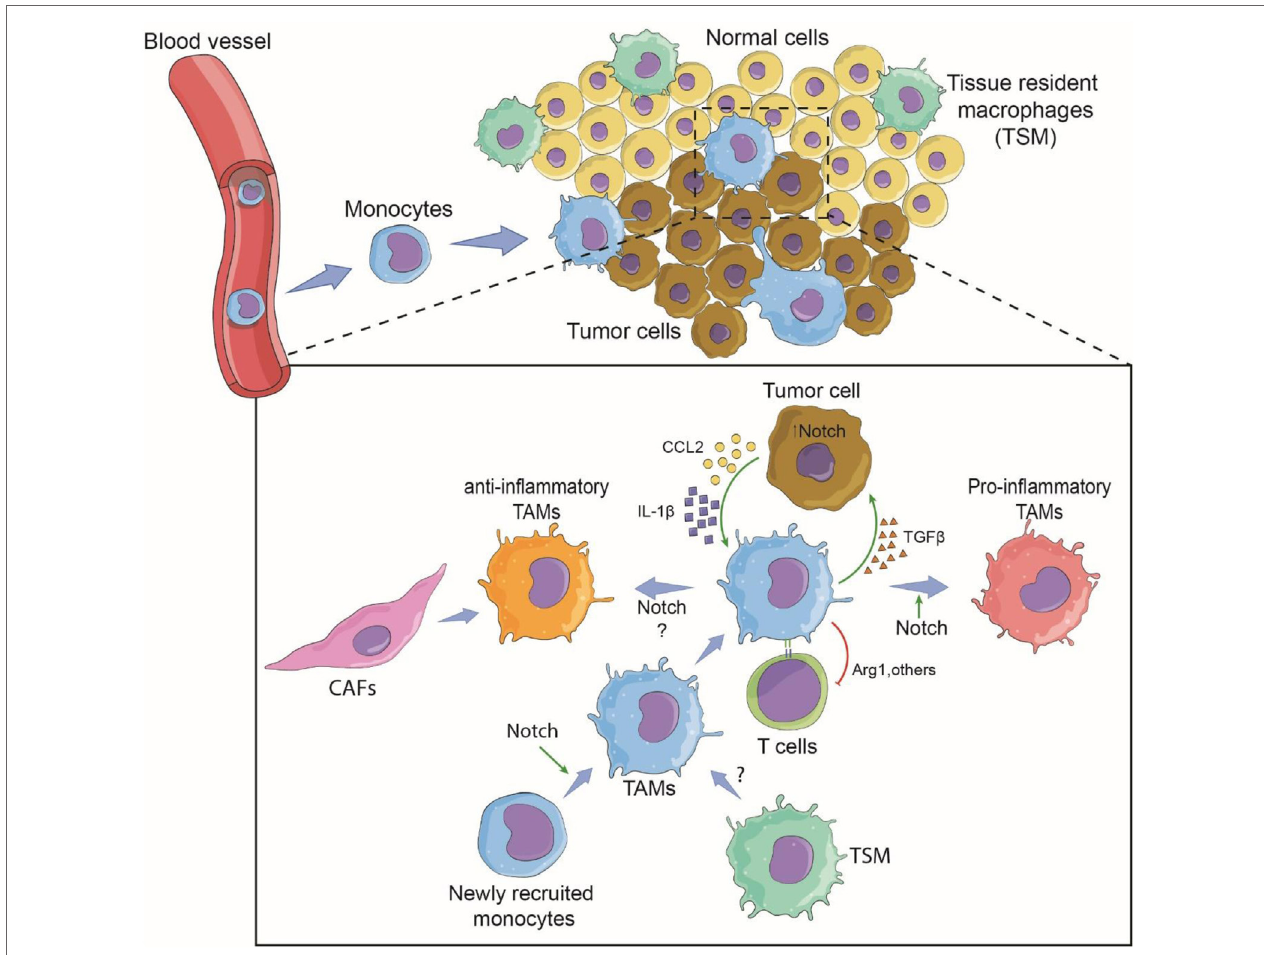
FigURe 1 | Involvement of Notch signaling during tumor-associated macrophage (TAM) differentiation and tumor growth. Tumor cells recruit monocytes from circulation by secreting chemotactic factors and inflammatory cytokines. Notch signaling may be required for terminally differentiated TAMs. Within the tumor microenvironment, newly recruited monocytes are conditioned to become pro-inflammatory or anti-inflammatory TAMs via the cytokine milieu and possibly the canonical Notch signaling (14). Tissue-resident macrophages may also contribute to tumor growth by changing to TAMs. TAMs support tumor growth directly by secreted cytokines and growth factors, and indirectly by affecting T-cell response against the tumor (37). The pro-tumoral function can be Notch signaling dependent or independent. Cancer-associated fibroblasts (CAFs) may also cross-talk with TAMs via Notch signaling